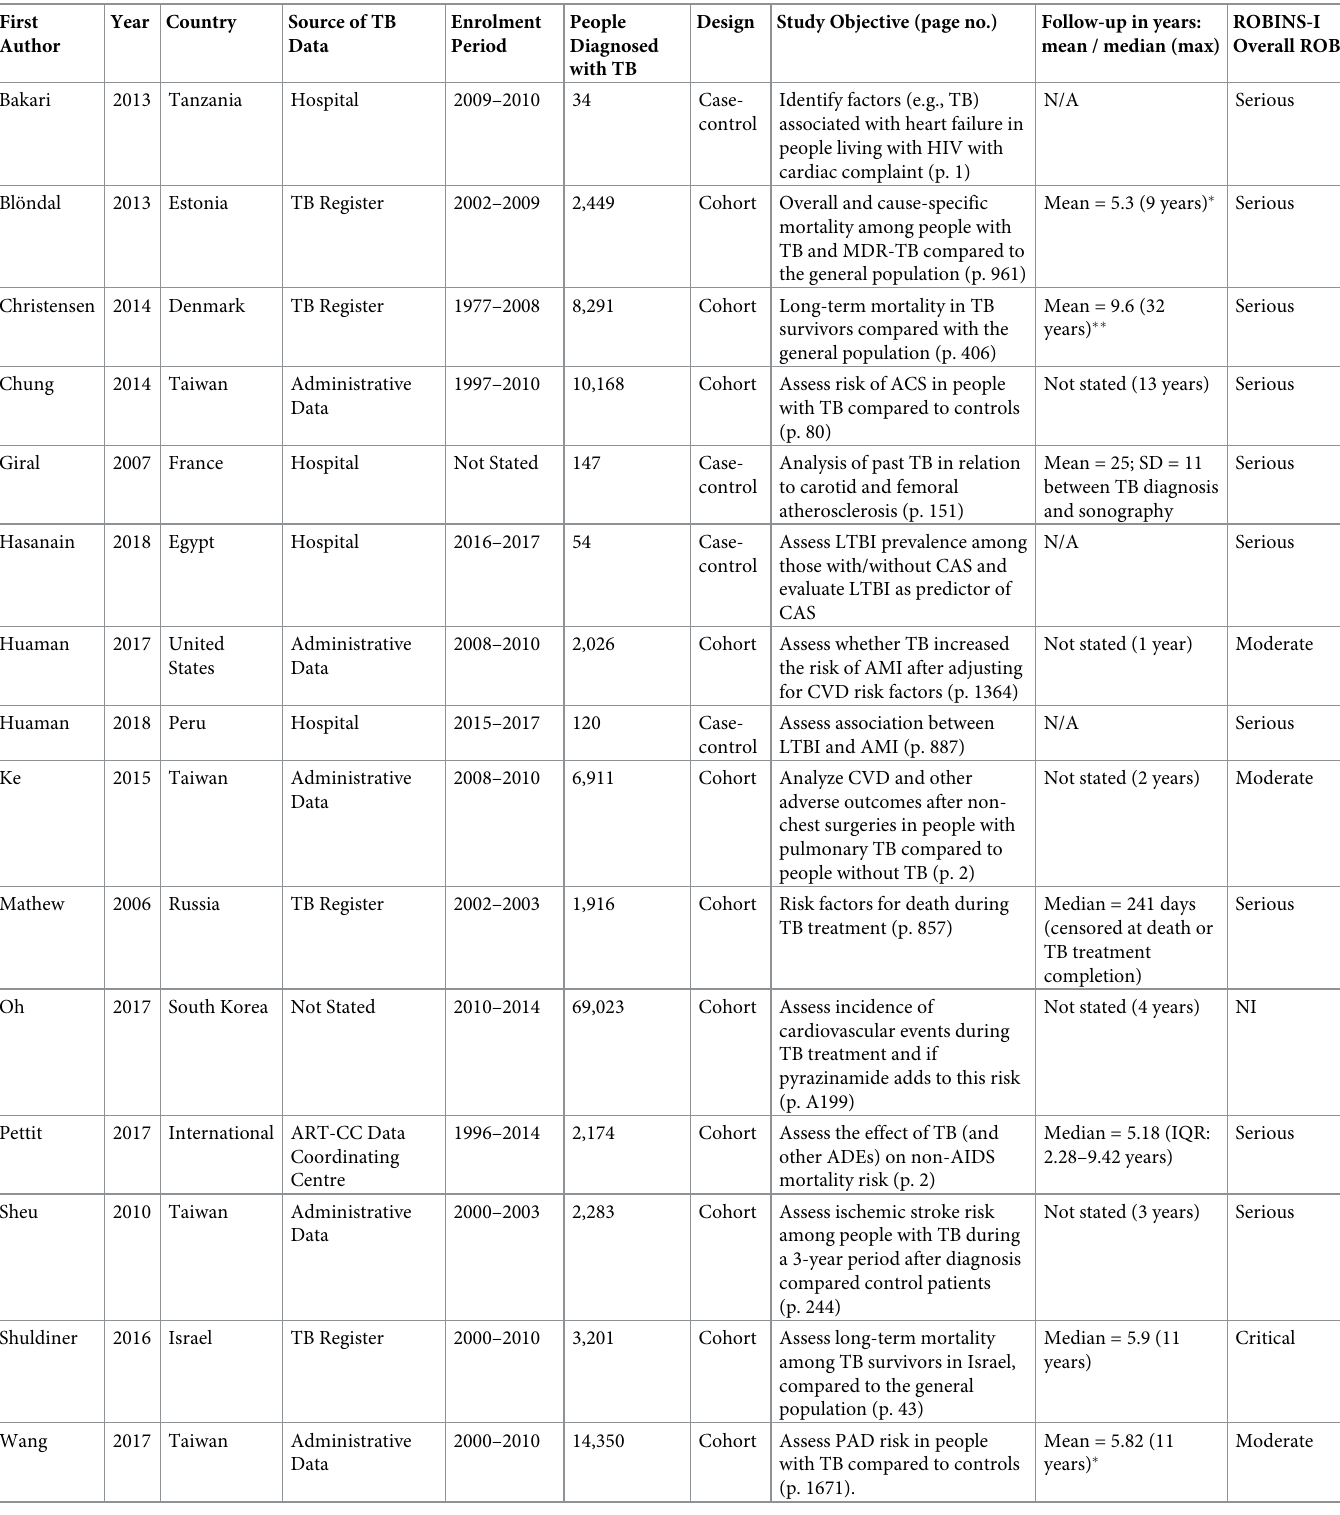
Table 1. Characteristics of included studies for systematic literature review of tuberculosis and risk of cardiovascular disease and related